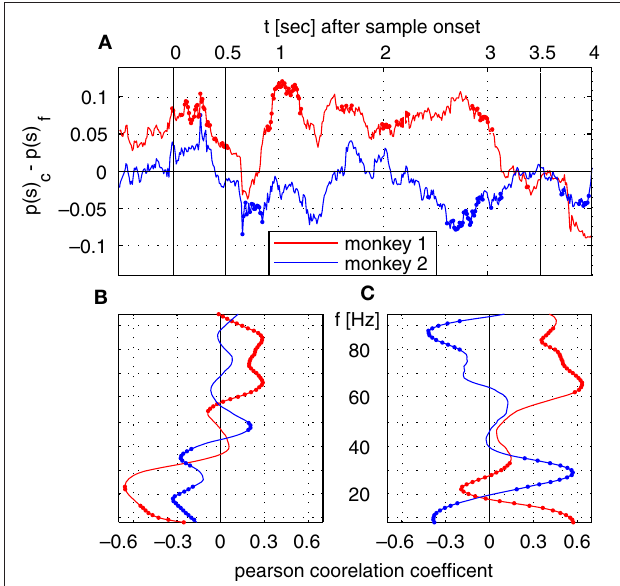
FIGURE 6 | Time course of saccade probability and correlation analysis with time course of λ (A) Difference in saccade probability in trials with c. correct and incorrect behavioral responses per sliding window for monkey 1 (red) and 2 (blue). Dotted segments identify periods which are signifi cantly different (1% level) from zero. (B,C) Pearson correlation coeffi cients for monkey 1 (red) and monkey 2 (blue) for time course of saccade probability difference of saccades per sliding window displayed in (A) and the percentage of sites with increased power (B) or pairs of sites with increased phase- locking (C) for trials with correct behavioral